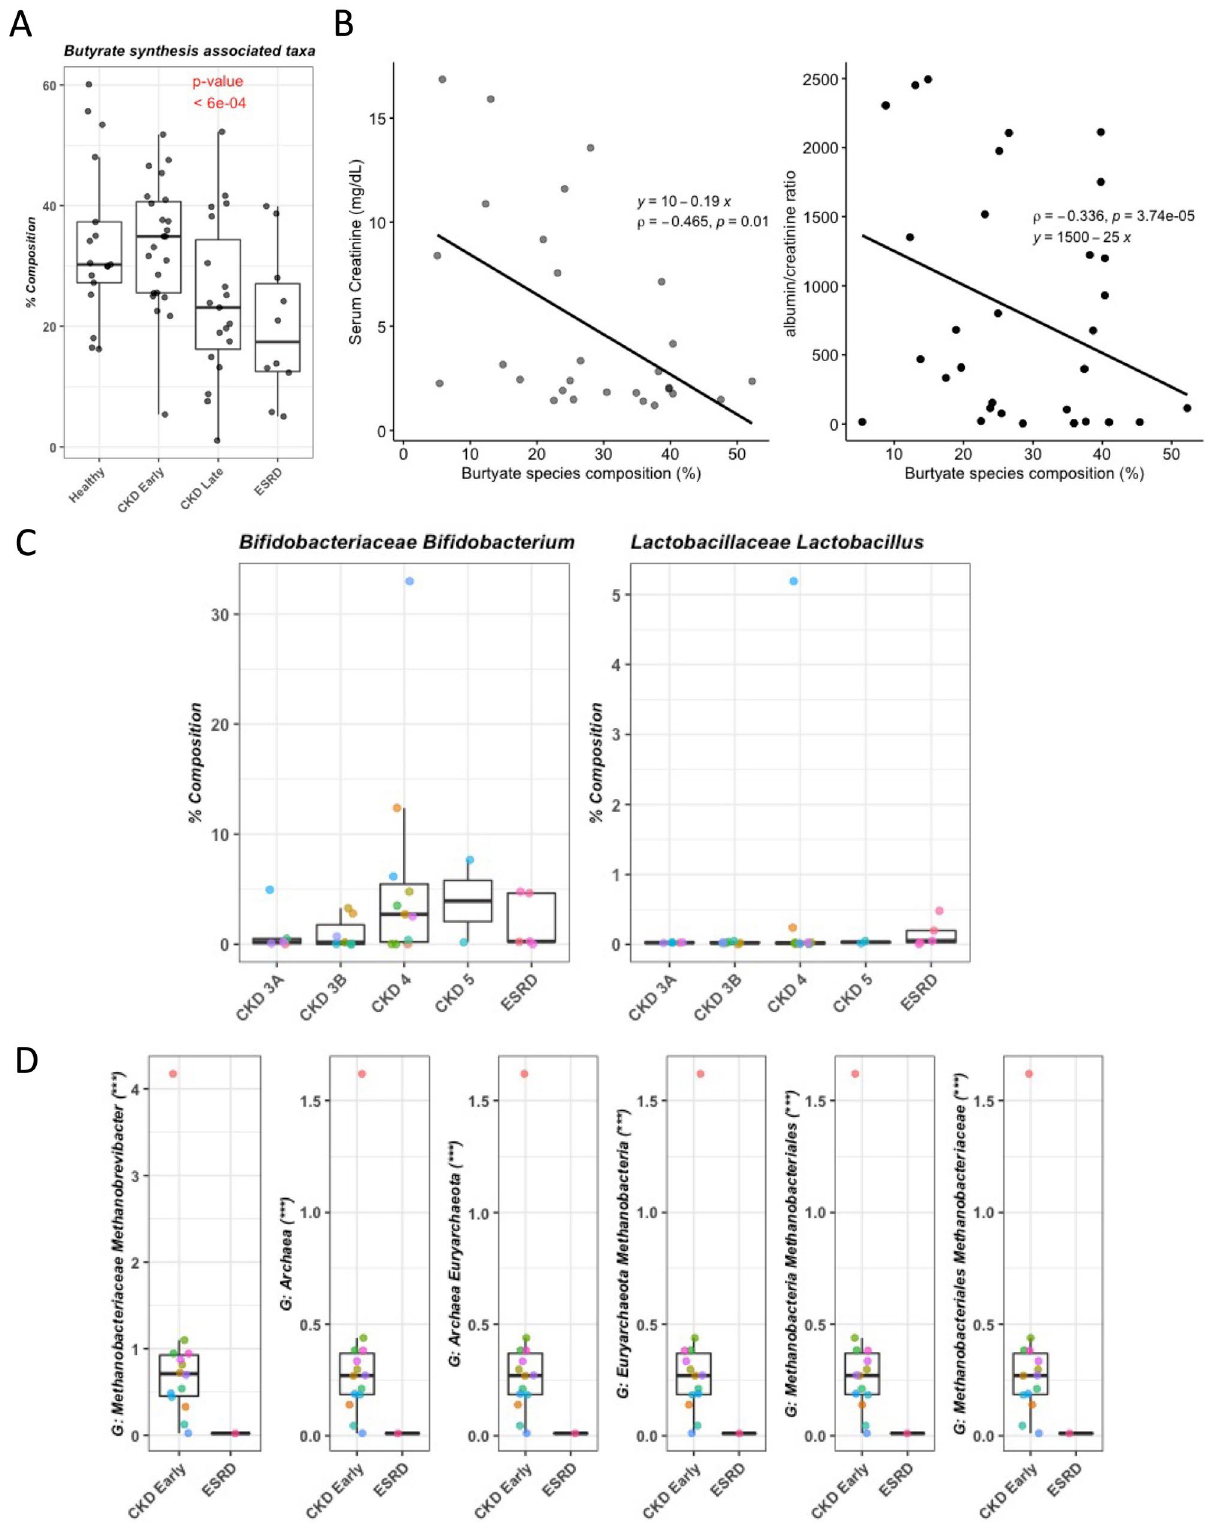
Figure 3. Key microbial taxa. ( A ) Butyrate synthesis associated taxa. P-value was calculated using linear mixed effect modelling. ( B ) The serum creatinine level shows statistically significant (p-value = 0.01) negative association with butyrate synthesis associated species composition (Left). The albumin/creatinine ratio in the serum shows statistically significant (p-value = 3.74e−5) negative association with butyrate synthesis associated species composition (Right). The spearman correlation was used for estimating association. ( C ) Bifidobacterium and Lactobacillus . ( D ) Methanobacteria . ***FDR < 0.0005; **FDR < 0.005; *FDR <